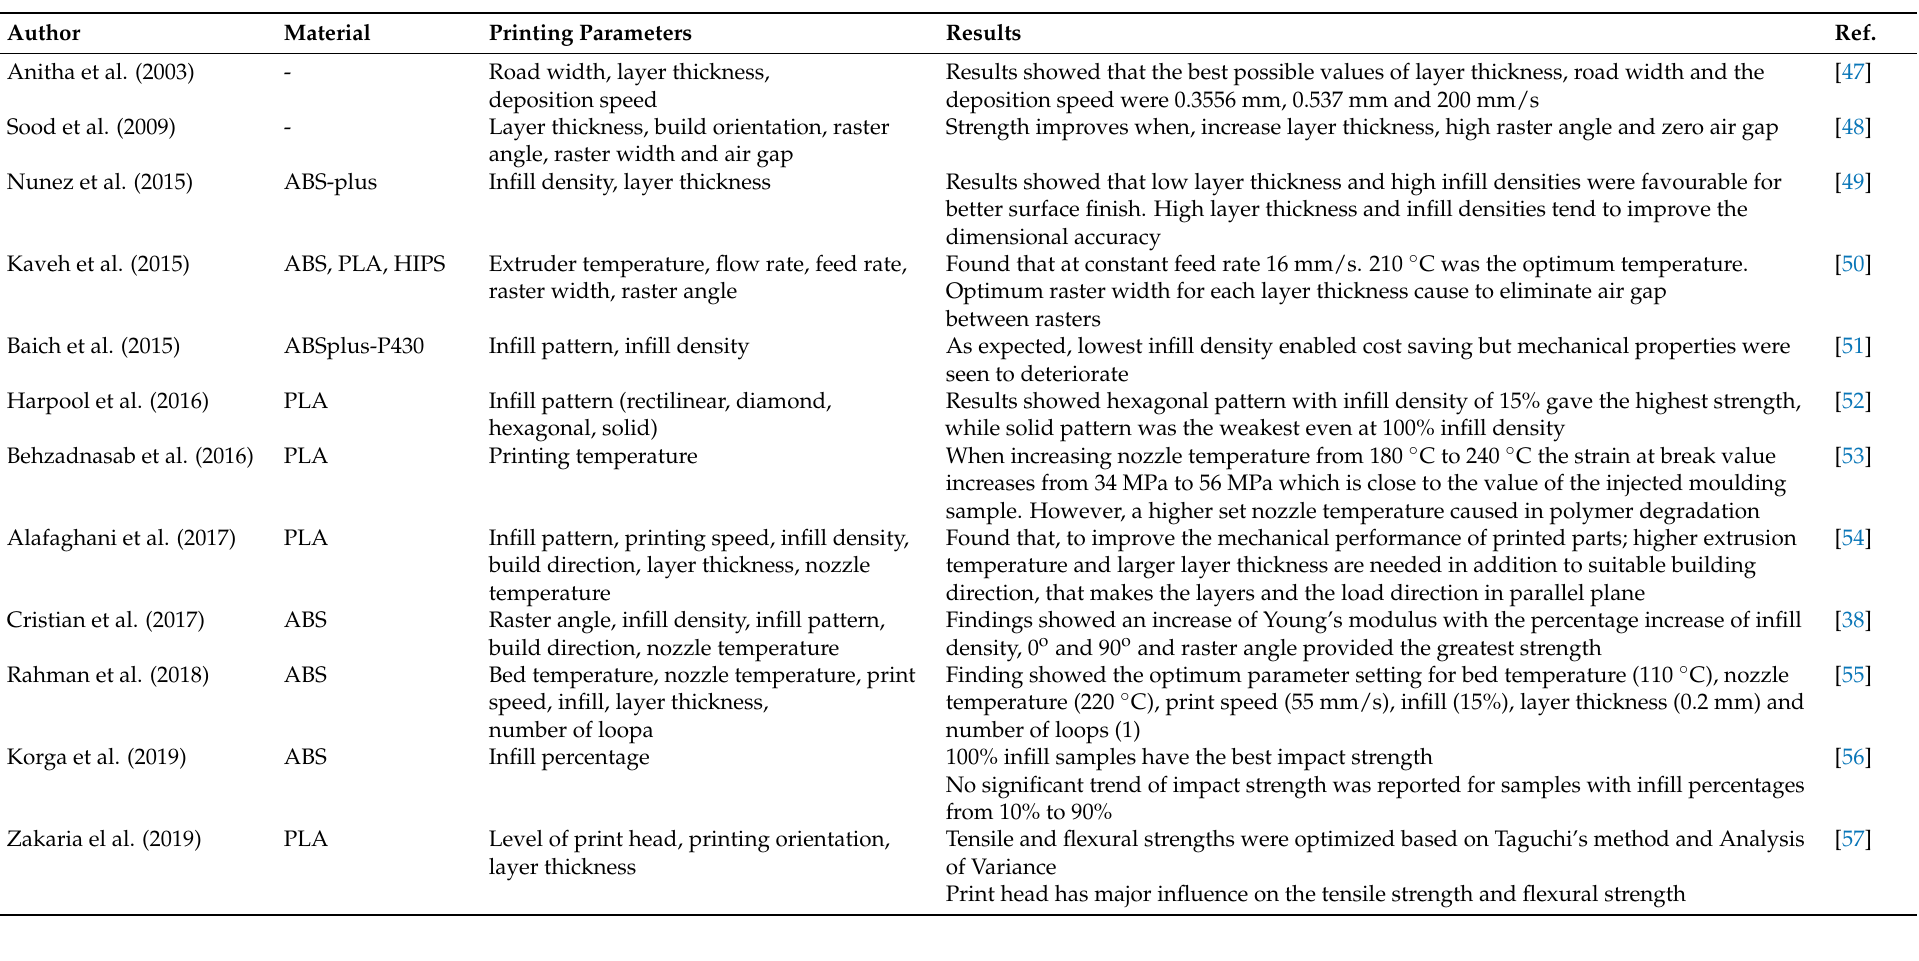
Table 2. Examples of previous research in printing parameters